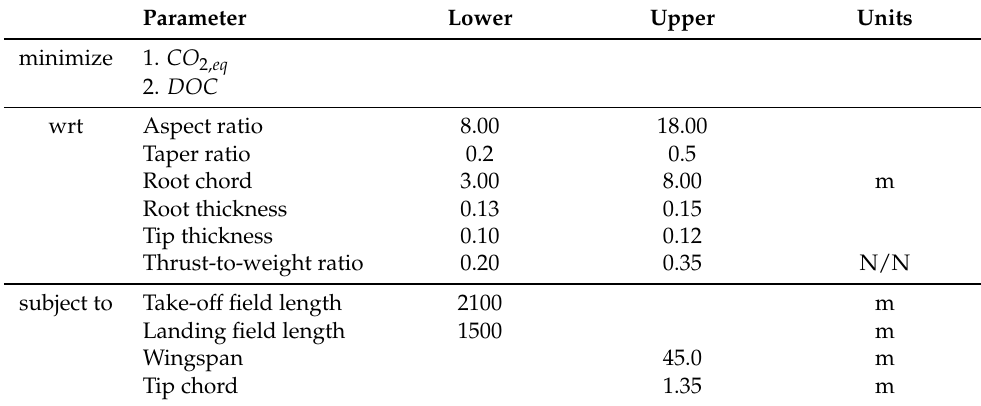
Table 4. SE 2 A MR aircraft optimization problem